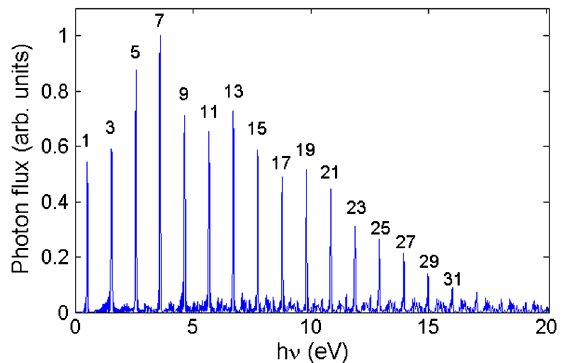
FIG. 2. Single electron on-axis photon flux from a 120 MeV electron. In the simulation the radiation is integrated over a 0.1 mm by 0.1 mm area at a distance 4 m downstream of the